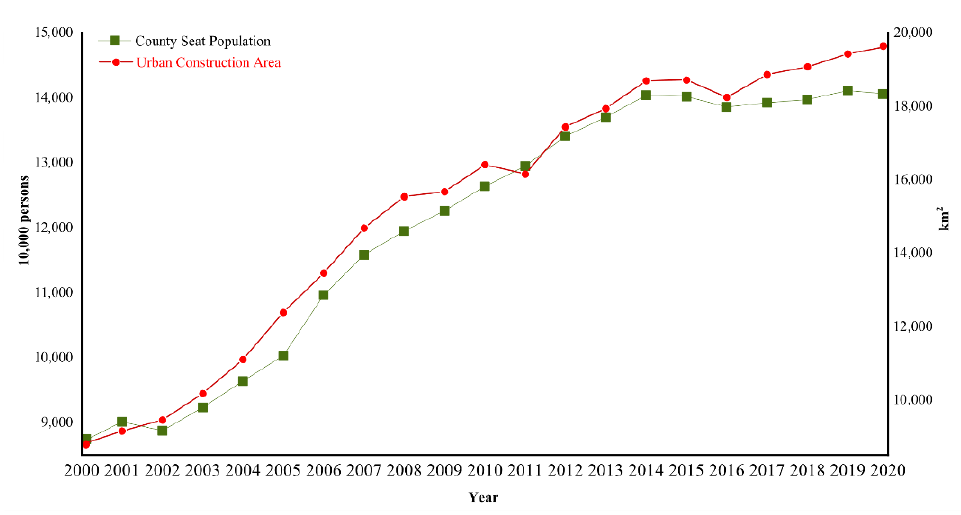
Figure 8. Changes of population size and construction area of county seat in China (2000–2020).